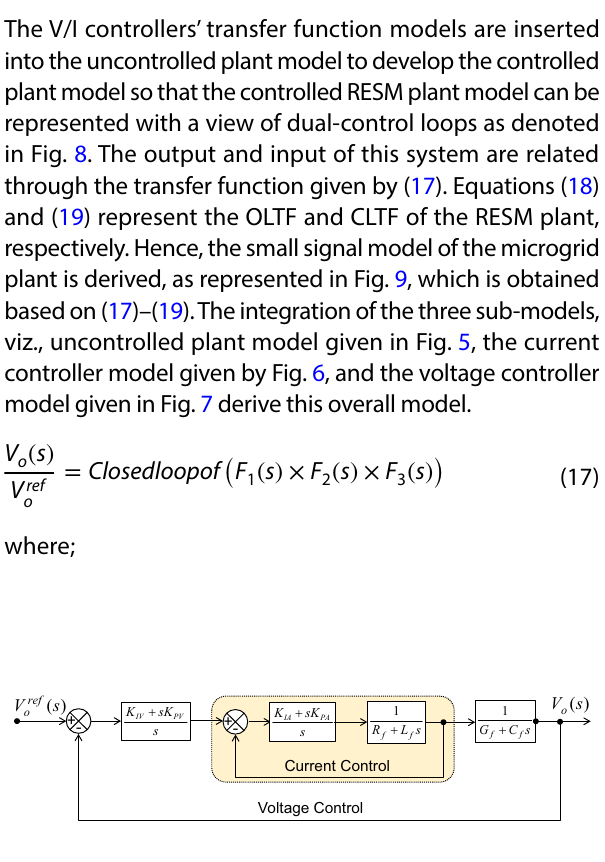
Fig. 8 Simplified dual-loop V/I controlled RESM